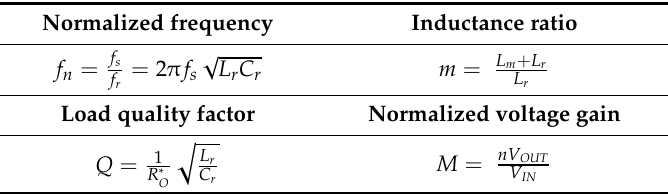
Table 2. LLC converter normalized parameters.